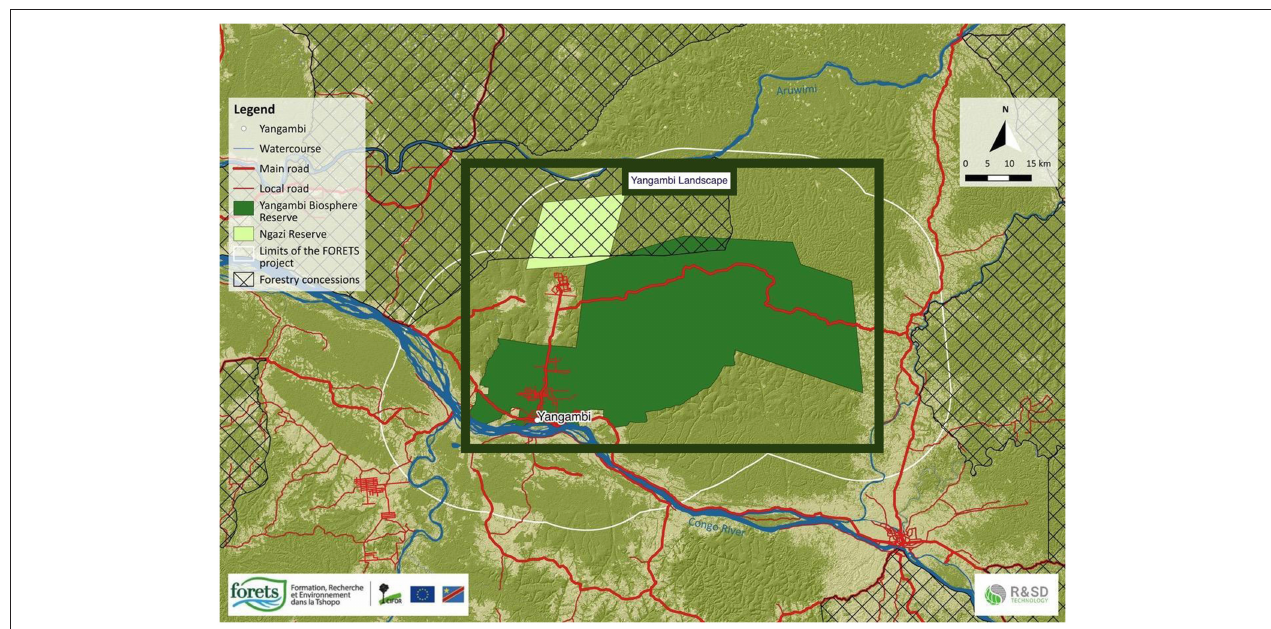
FIGURE 1 | Geographical location of the study